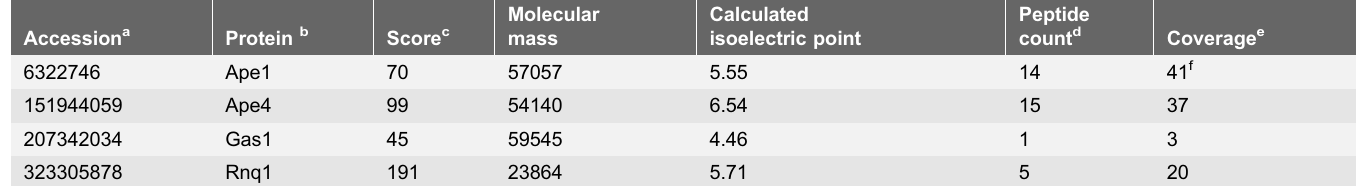
a GI number. b Standard protein names are indicated. c MASCOT protein score. d Number of unique peptides matched to mass peaks. e Sequence coverage in percent. f Percent of coverage without GFP sequence is